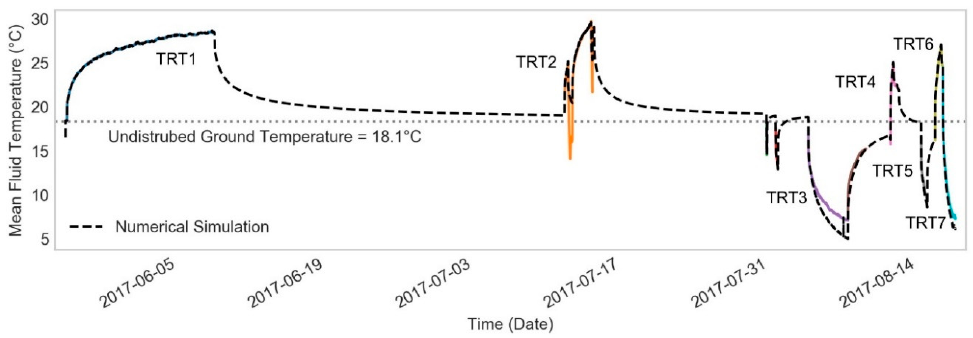
Figure 6. Forward simulation of all TRTs.